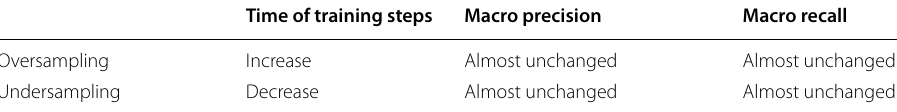
Table 48 Oversampling and Undersampling in not extremely Imbalanced Datasets Time of training steps Macro precision Macro recall Oversampling Increase Undersampling